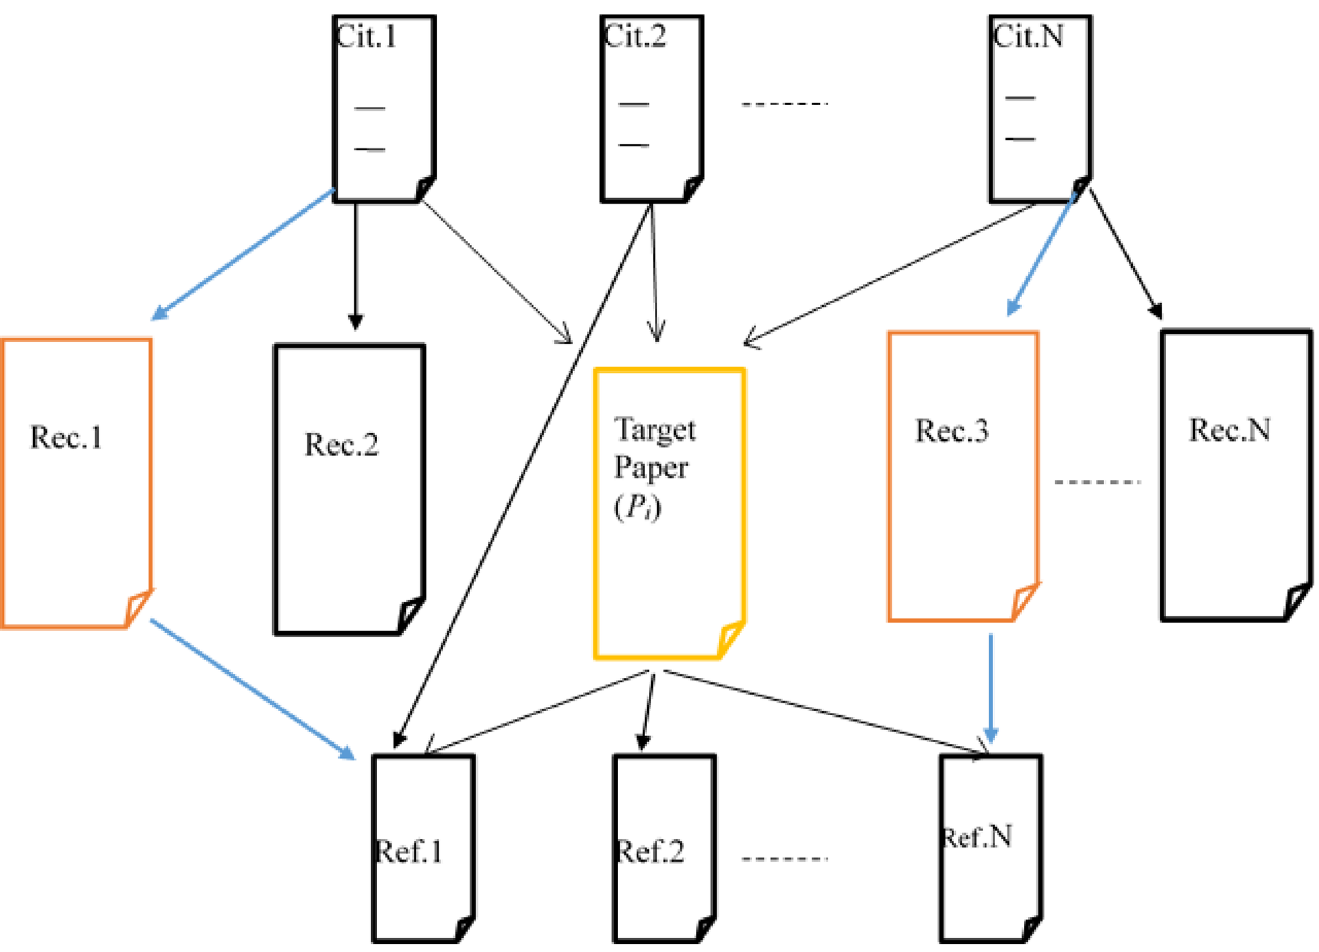
Fig 1. Proposed recommendation scenario.